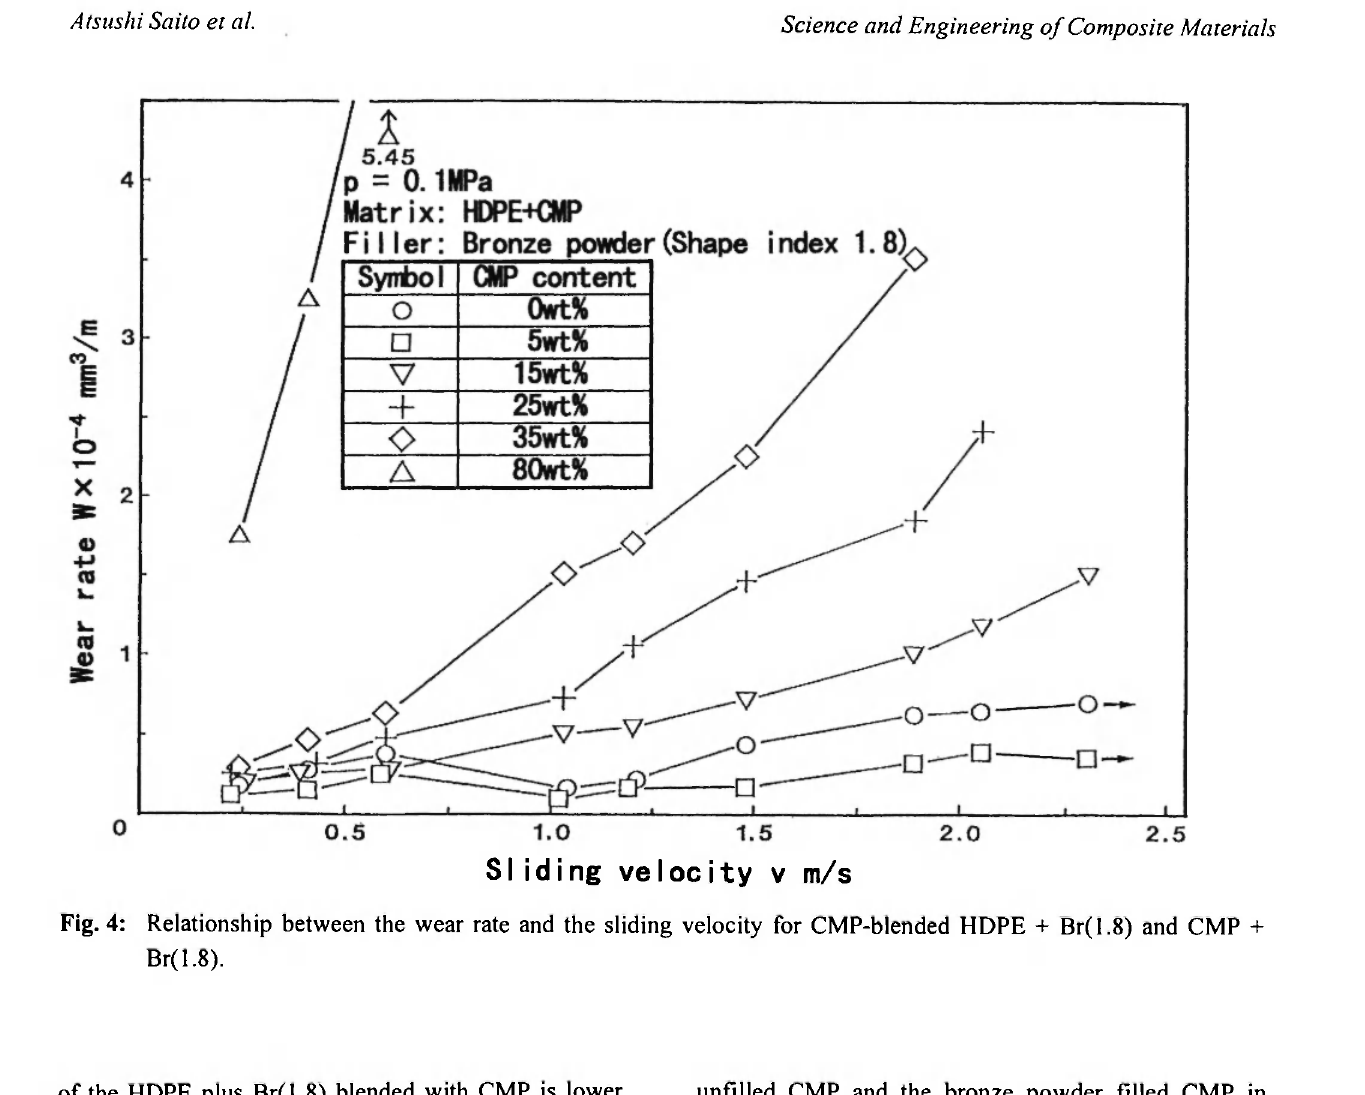
Fig. 4: Relationship between the wear rate and the sliding velocity for CMP-blended HDPE + Br(1.8) and CMP +